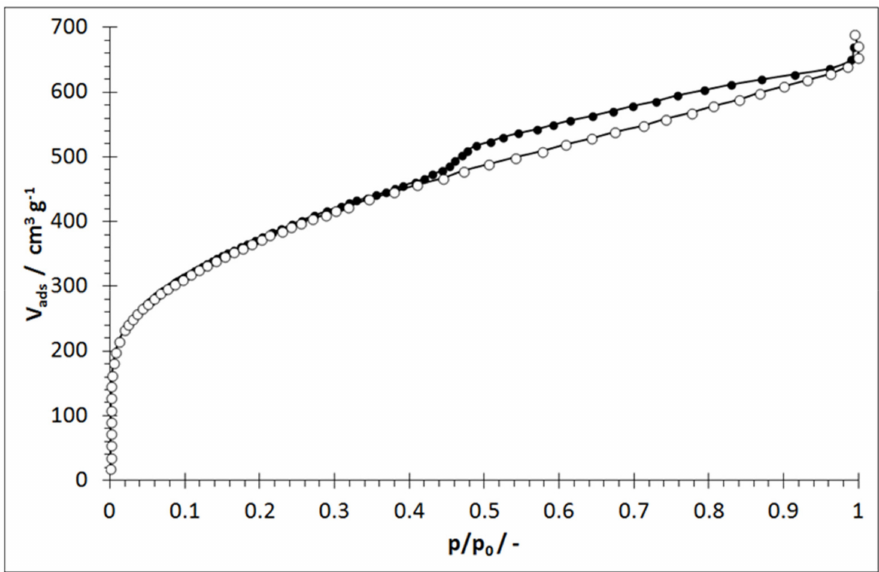
Figure 1. Nitrogen adsorption isotherm of BAX 1100 at T = − 196 ◦ C, p 0 ( − 196 ◦ C) = 1013.5 hPa.